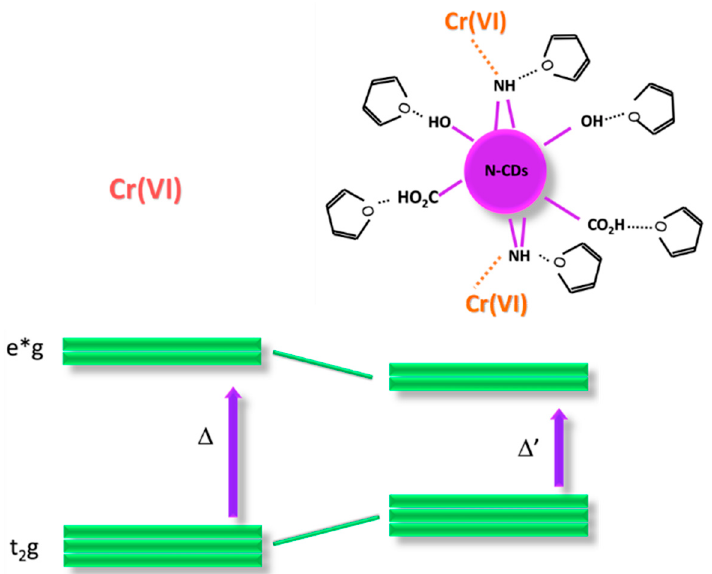
Scheme 1. Cr(VI) and the corresponding energy gap ( Δ ), which corresponds to the transition energy, right side, selective interaction of Cr(VI) with N-CDs hydrogen bonded with THF, and corresponding reduction of the energy gap ( Δ ’).